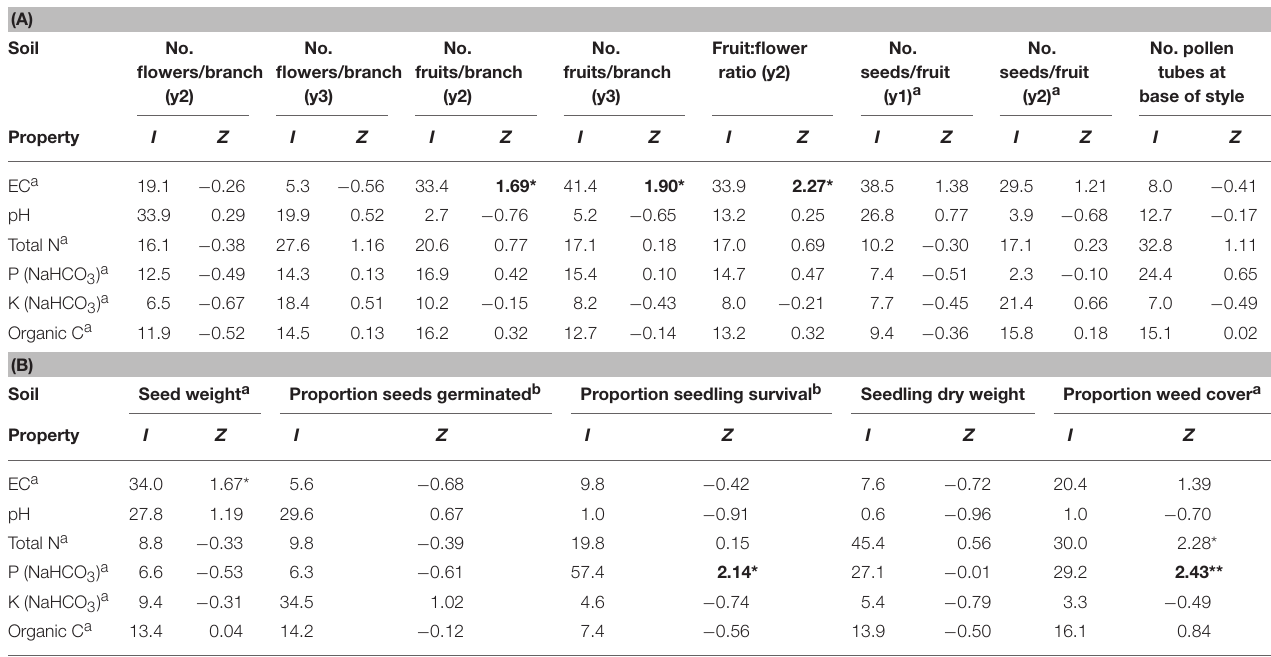
TABLE 5 | The percentage independent contribution (I) of soil chemical properties to (A) reproduction and (B) progeny performance and weed cover for 19 populations of Eucalyptus wandoo , determined by hierarchical partitioning. (A)